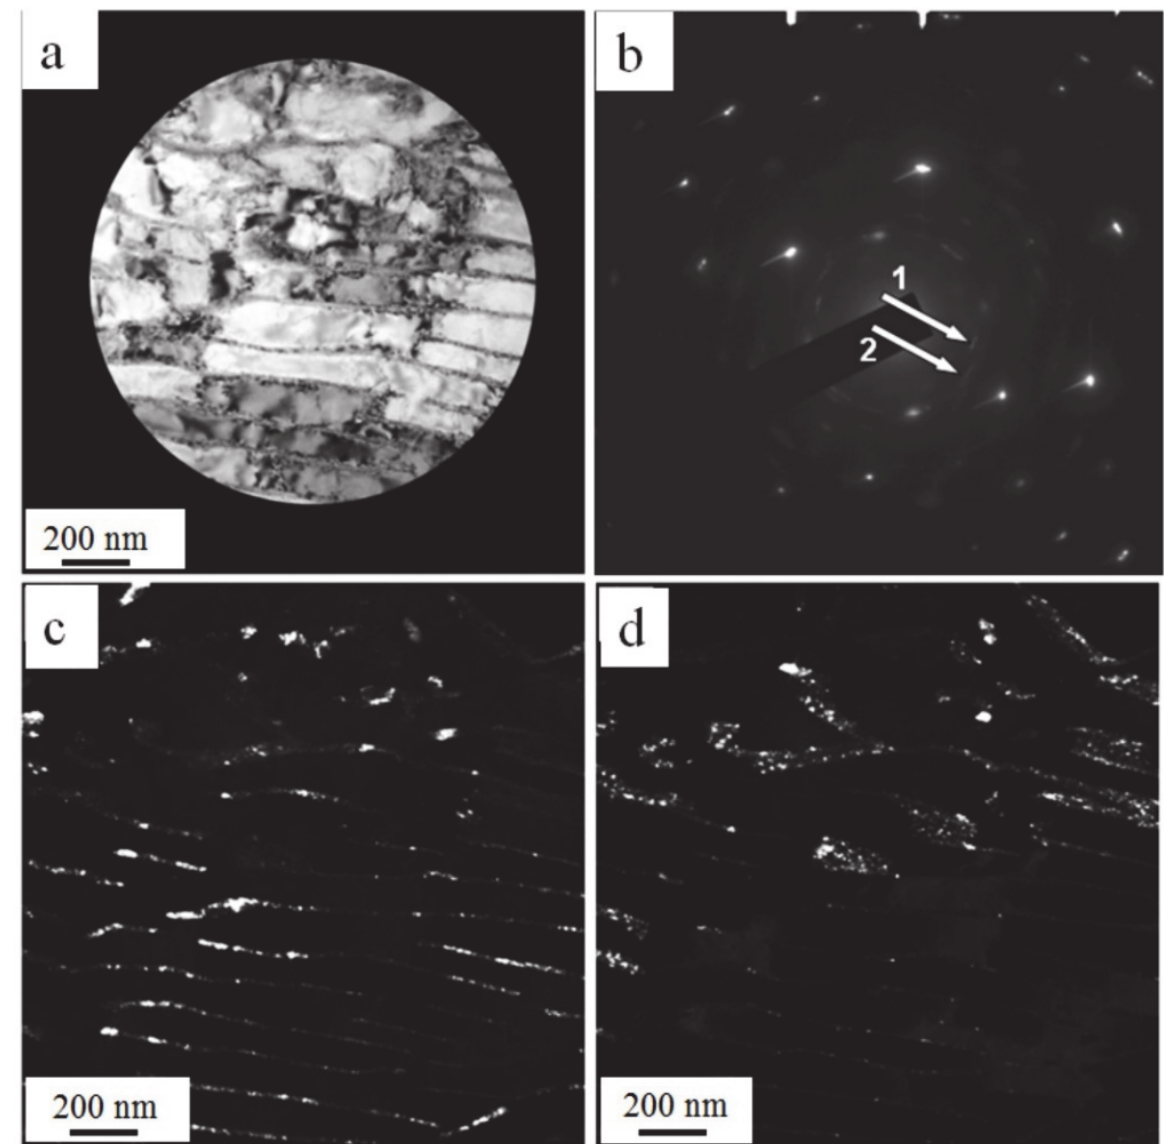
Figure 3. A TEM image of the steel deformed structure ( ε = 50%); ( a )—bright field; ( b )—microelectron diffraction pattern obtained from a foil portion whose image is given on ( a ); ( c , d )—dark fields obtained in cementite reflections [121] Fe 3 C ( c ) and [211] Fe 3 C ( d ). On ( b ) arrows indicate reflections of dark fields, 1—( c ), 2—( d ).